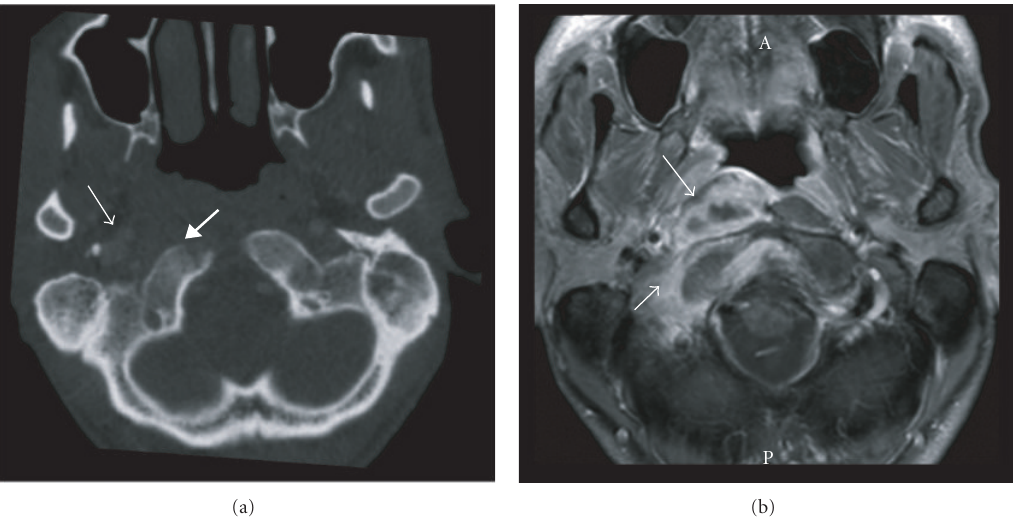
Figure 2: (Case B) Axial contrast-enhanced CT image in bone window (a) and axial T1-weighted MR image with fat suppression after administration of Gadolinium (b) at the level of the foramen magnum. Indicated in (a) are the mass on the right side of the nasopharynx (medium open arrow) and lysis of the clivus (medium closed arrow). The abscess in the retropharyngeal space and prevertebral muscle is better appreciated on MR (b, medium open arrow); edema in the clivus and occipital bone as well as paravertebral soft tissues are also indicated (short open